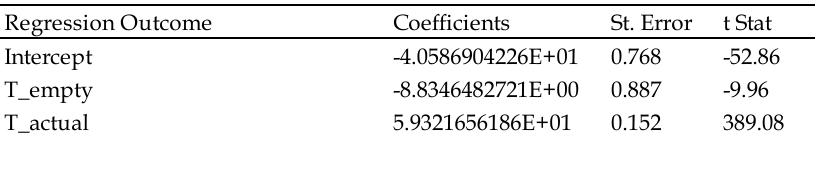
Results of the first regression model for defining the capacity